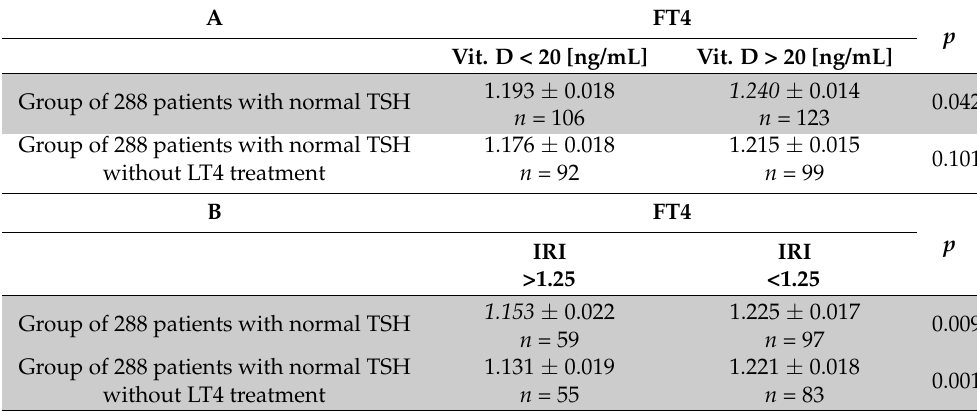
Table 6. Mean FT4 concentration in patients with/without severe vitamin D deficiency (<20 ng/mL/ ≥ 20 ng/mL) ( A ) or with/without abnormal IRI (>1.25/ ≤ 1.25) ( B ), evaluated in the group of 288 inpatients with normal TSH (and also after excluding individuals on LT4 treatment). A FT4 Vit. D > 20 [ng/mL]